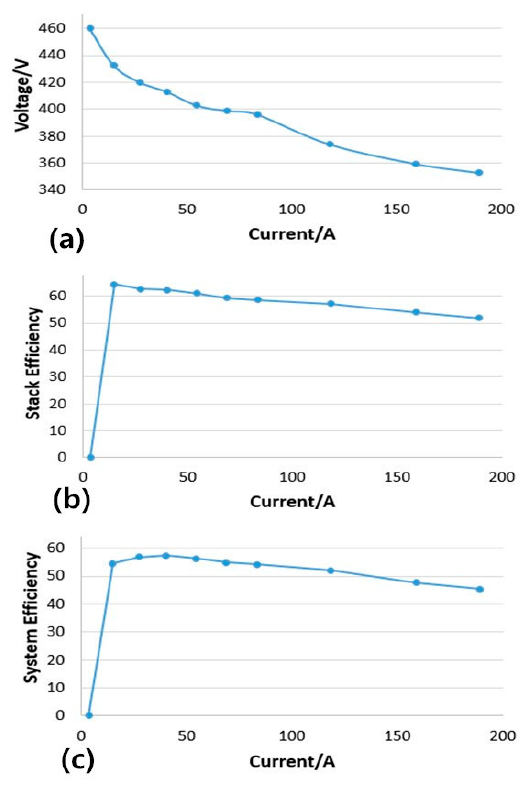
Figure 3. ( a ) The I-V curve of the PEM fuel cell; ( b ) The relationship between stack efficiency and current of the PEM fuel cell; ( c ) The relationship between system efficiency and current of the PEM fuel cell.